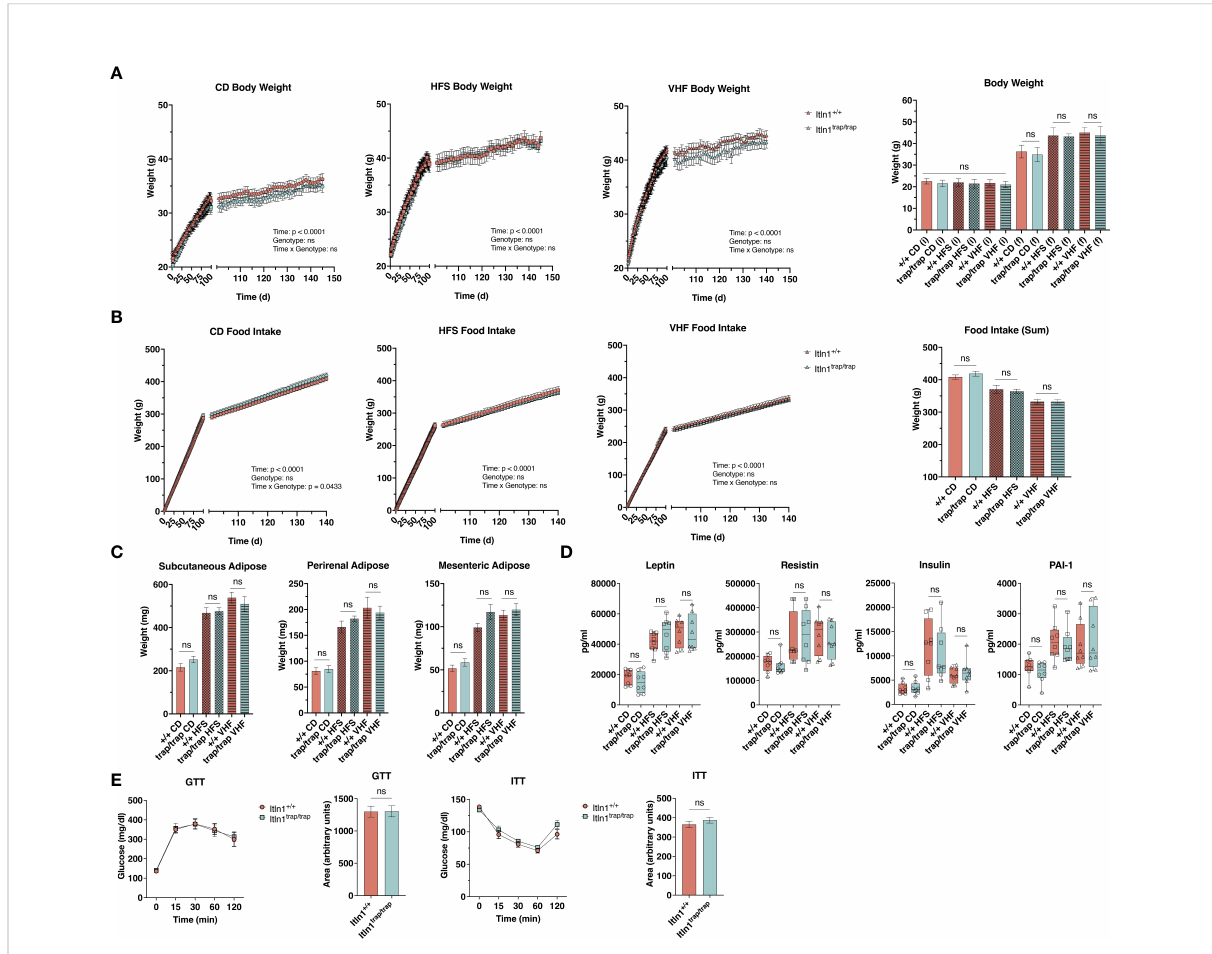
FIGURE 3 Response to obesity-inducing diets by intelectin-1 knockout mice. (A) Daily body weight and (B) food intake by Itln1 +/+ and Itln1 trap/trap mice (n = 8 – 9/group). Animals were fed control (CD; 10% kcals fat, 0% sucrose), high-fat sugar (HFS; 45% kcals fat, 17% kcals sucrose), or very-high fat (VHF; 60% kcals fat, 7% kcals sucrose) chow for approximately 145 d. (C) Adipose depot weights and (D) serum adipokines at necropsy. (E) Intraperitoneal glucose- and insulin-tolerance tests, and associated area under the curve analyses in CD-fed animals (n = 6/genotype). Statistical analysis of daily body weight and food intake was performed using repeated measures two-way ANOVA with Greisser-Greenhouse correction and Sidak multiple comparisons test. Comparison of mean differences in body weight, food intake, adipose weight, and serum adipokines were performed using a one-way ANOVA with Tukey ’ s multiple comparisons test. Mean differences in glucose and insulin tolerance (area under the curve) were compared using two-tailed, unpaired T-tests. Displayed analyses represent genotype comparisons within diet groups. ns, non-signi fi